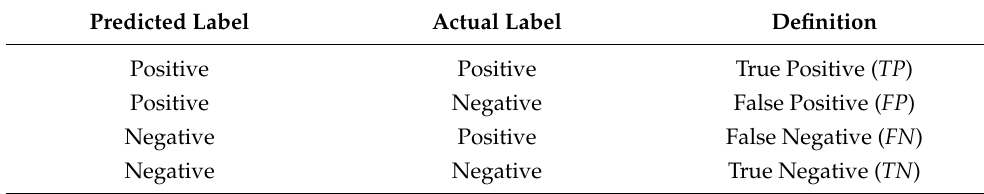
Table 2. Definition of accuracy